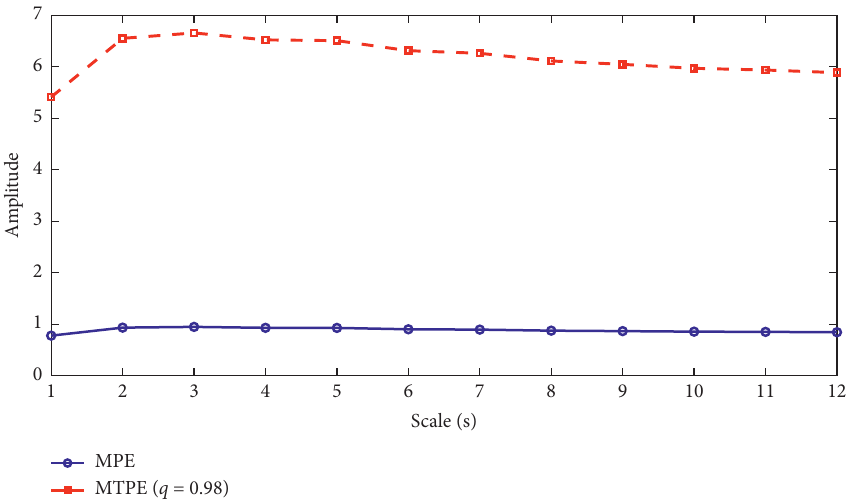
Figure 1: Comparison of MPE and MTPE with different scales.